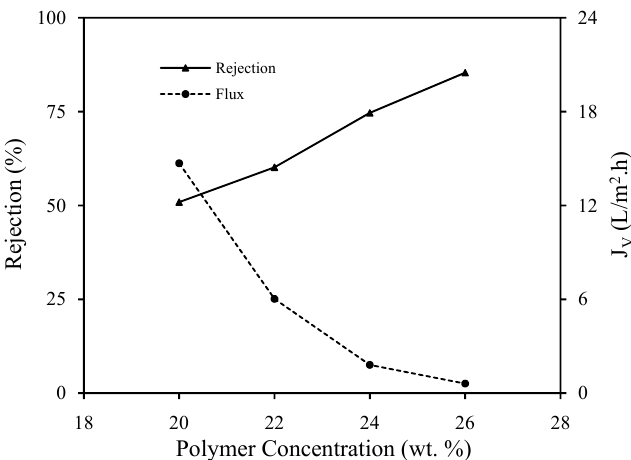
Fig. 5. Permeate flux and cobalt ion rejection percentage by the pure PES membranes versus the polymer concentration (wt.%), (20 bar, 40 L/h, 20 ppm Co(NO 3 ) 2 , pH=5.5 ± 0.1, 90 min)